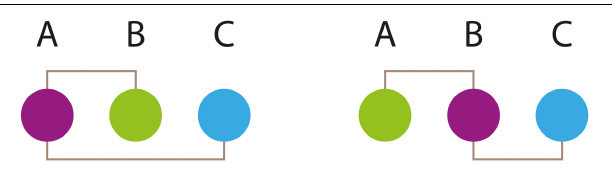
FIGURE 4 | A simple illustration of the “saving wire” principle. This principle states that in a neural circuit the placement of the different components is such that the addition of all internodes (between neuronal bodies) distances tends to be minimized. Experimental analysis of many neural circuits in different animals has shown that the principle if followed in most cases. The principle is here illustrated in a very simple circuit with only three components (neurons). When connection length among components is calculated, the placement of components in the left panel requires the greatest length. Adapted from Cherniak